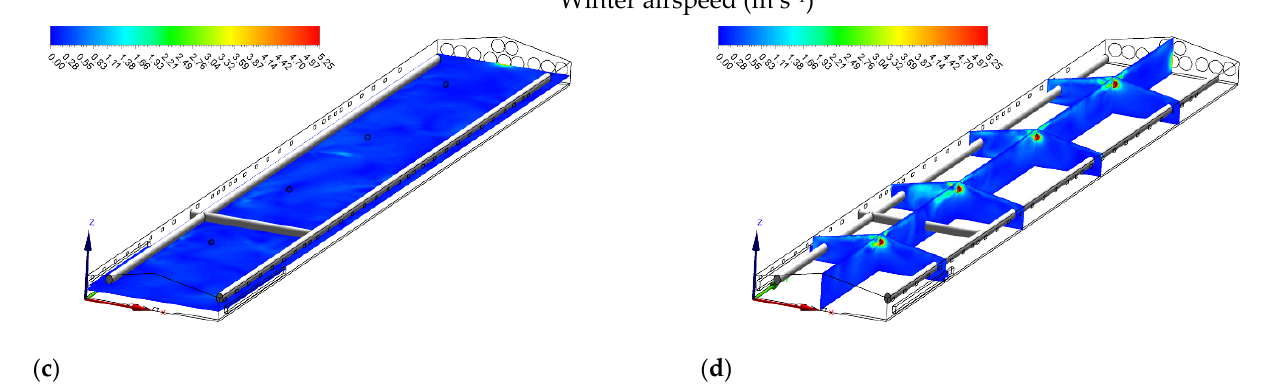
Figure 9. Temperature (°C) ( a , b ) and airspeed (m s − 1 ) ( c , d ) contours of slice: z = 1 m, and y 1 = 15 m, y 2 = 35 m, y 3 = 55 m, y 4 = 75 m, and x = 7 m in winter when installing circulation fans.